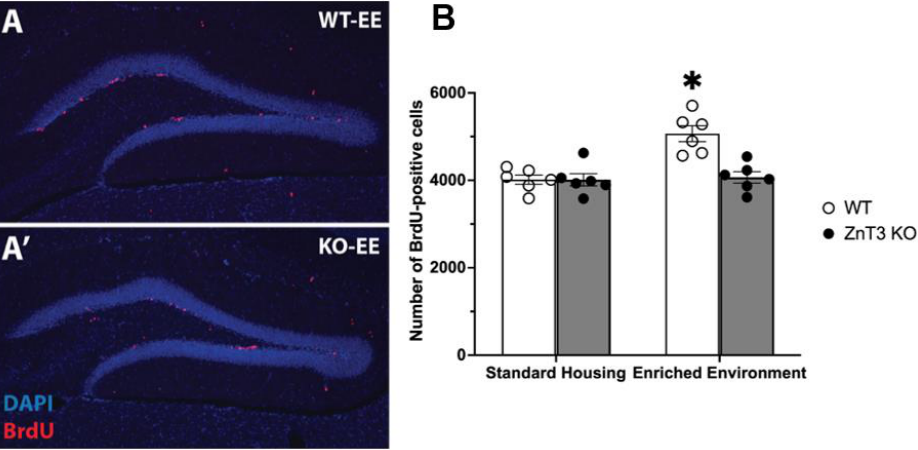
Figure 1. Cell proliferation in the hippocampus of WT and ZnT3 KO mice exposed to SH or EE ( n = 24). Representative photomicrographs of DAPI (blue) and BrdU-immunopositive cells (red) in the subgranular zone of a ( A ) WT and ( A’ ) ZnT3 KO mouse housed in EE. ( B ) The levels of cell proliferation seen in WT and ZnT3 KO mice placed in the SH condition did not differ. However, while WT mice in EE showed a significant increase in cell proliferation, the level of proliferation in ZnT3 KO-EE mice was significantly lower and was no different from levels in WT and ZnT3 KO mice in the SH condition. Error bars represent ± standard error of the mean. * indicates p < 0.001.